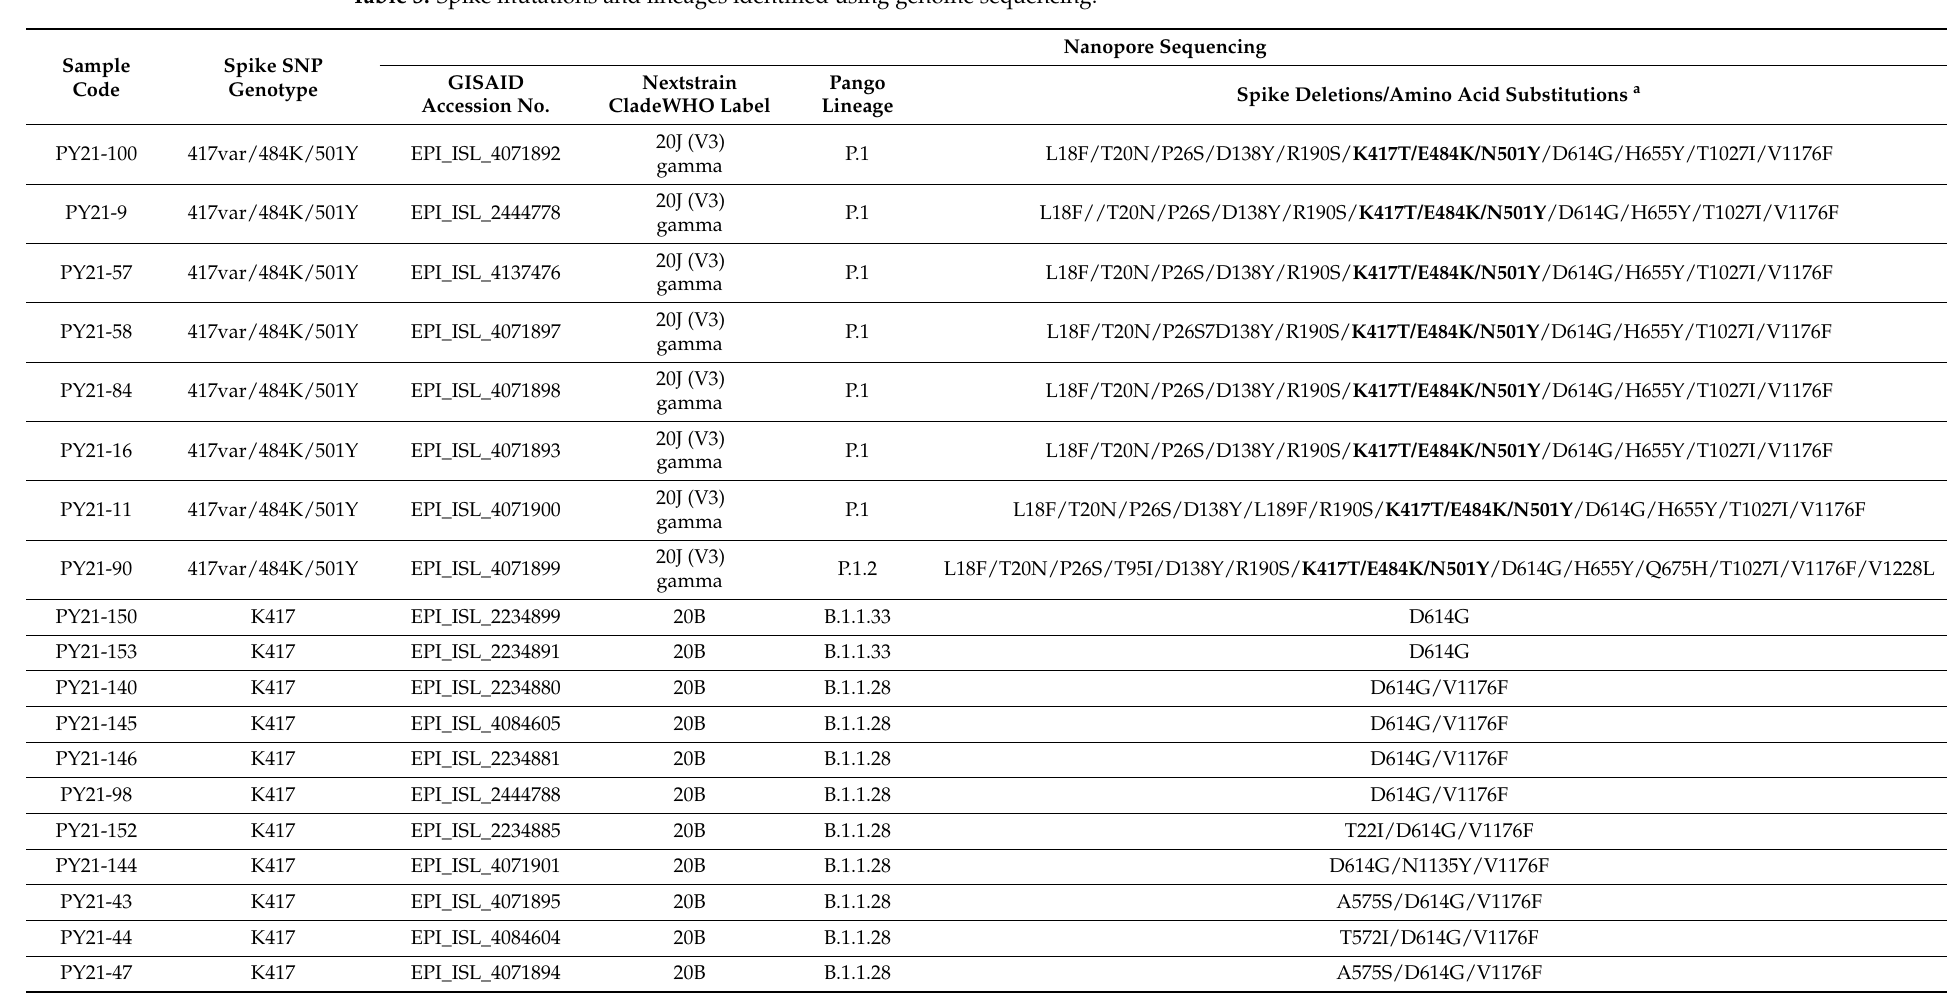
Table 3. Spike mutations and lineages identified using genome